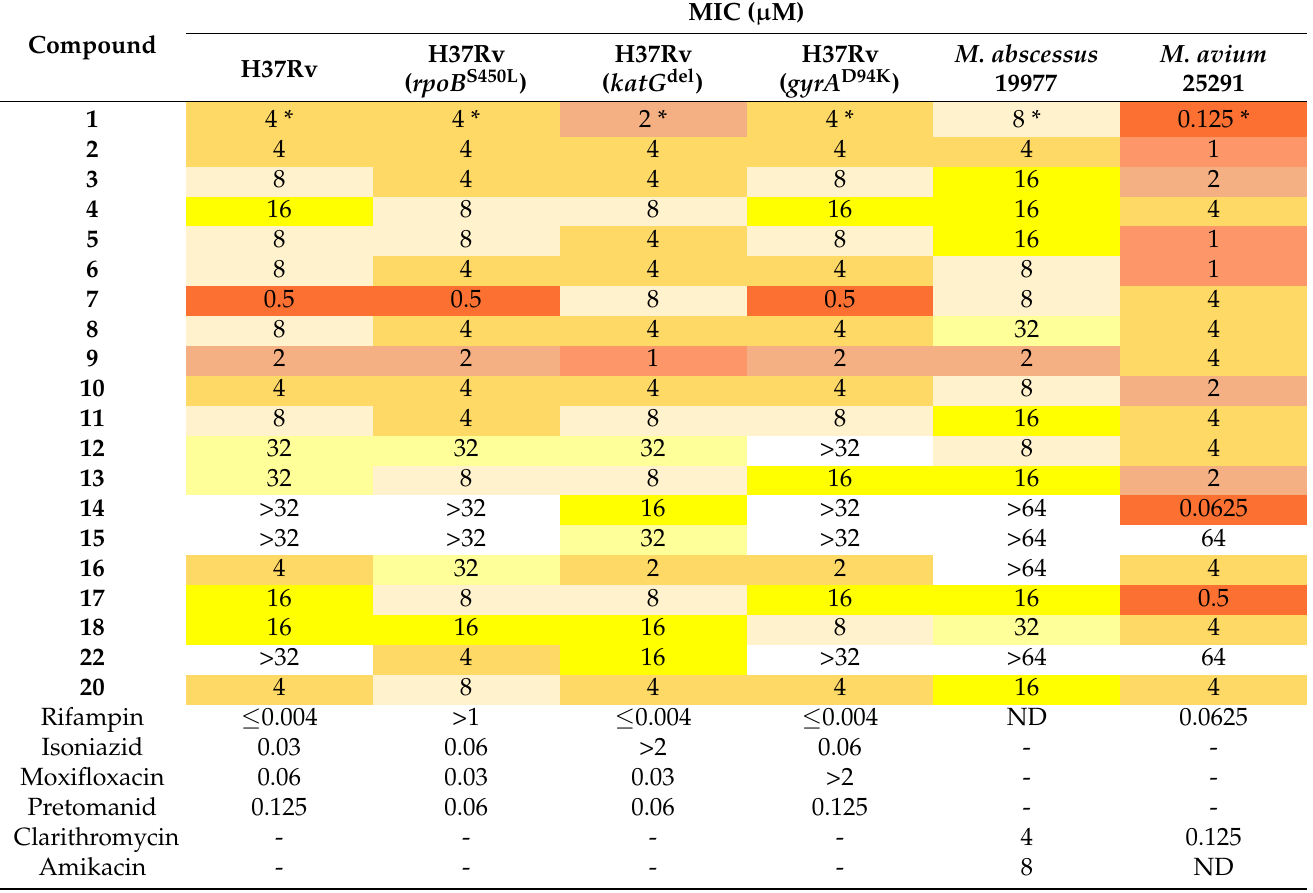
Table 3. Minimal inhibitory concentration of compounds 1–18 , 20 , and 22 against M. tuberculosis, mono-resistant MTB and NTM strain panels; active compounds are highlighted from low active (light yellow) to highly active (red).